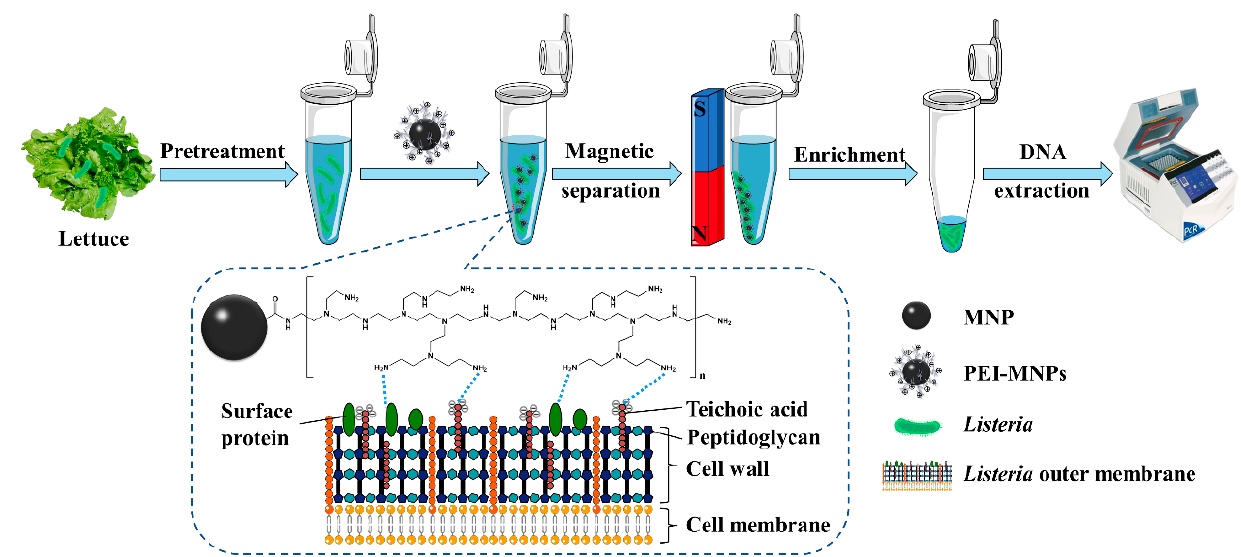
Figure 1. Schematic illustration of PEI-MNPs magnetic enrichment integrated with mPCR analysis for the simultaneous detection of pathogenic Listeria spp.